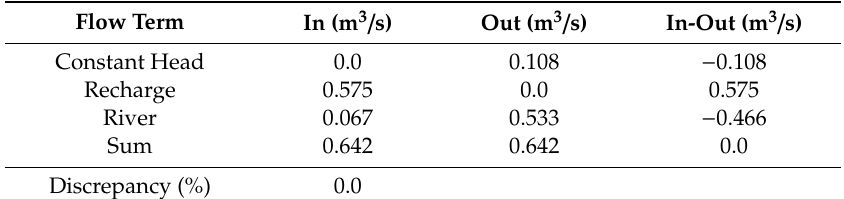
Table 2. Elements of the hydrogeological balance as calculated in the flow